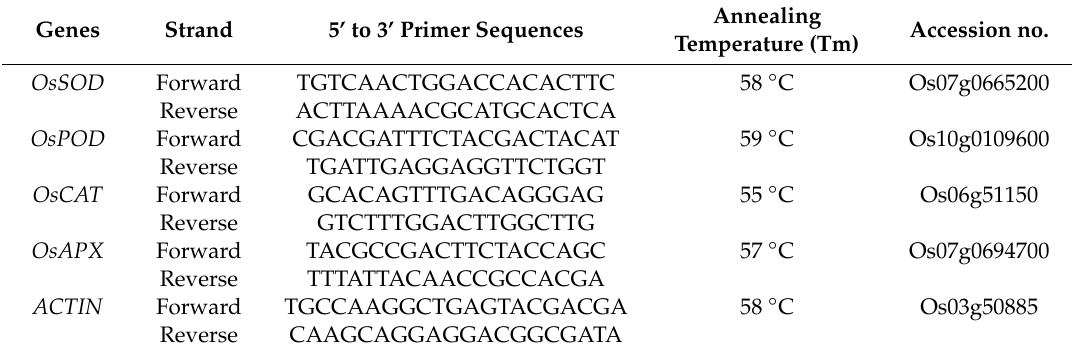
Table 1. Sequences of primers used for qRT-PCR.